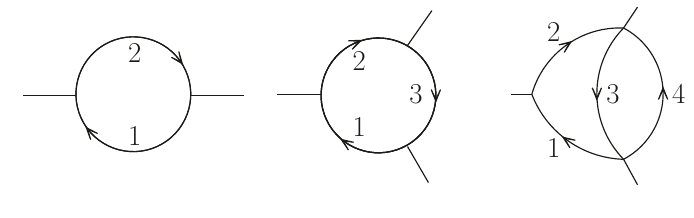
Figure 26 . Oriented